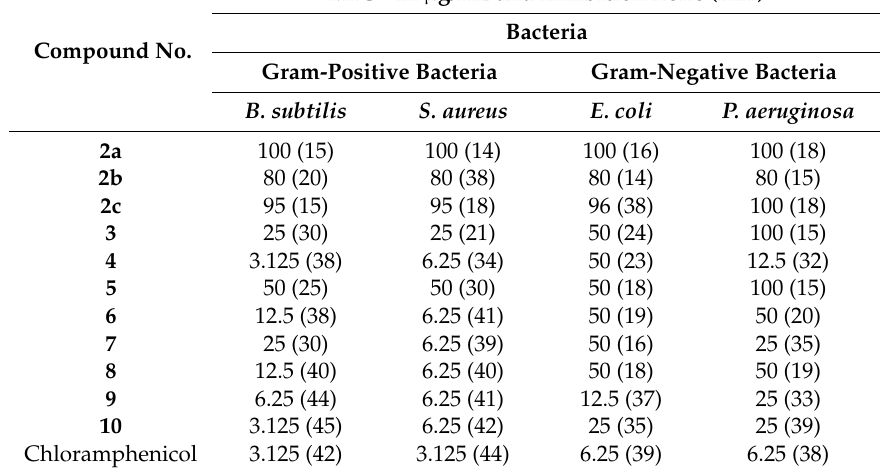
Table 2. Minimal inhibitory concentration (MIC, µg/mL) and inhibition zone (mm) of the tested compounds. Compound No. Compound